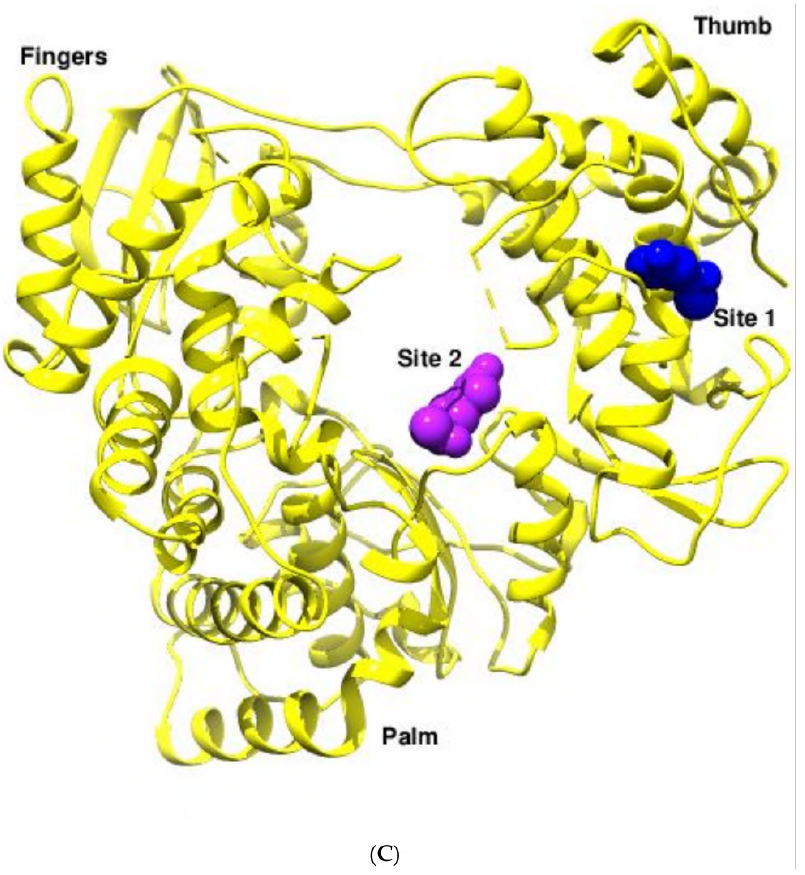
Figure 10. Inhibitor binding sites of DENV2 and SARS-CoV-2 RdRPs. ( A ) The binding sites of suramin derivatives in SARS-CoV-2 RdRP (yellow ribbon). The first one is near the active site (magenta), and the other site is located at the template binding region (blue). The NSP7 and NSP8 that are bound to the RdRP are shown in shades of blue. ( B ) The structure of SARS-CoV-2 RdRP with the bound nucleoside-analog remdesivir (green ball and stick). The template and the product are shown in yellow and orange, respectively. Ser861 obstructs the cyano group of the inhibitor during translocation. ( C ) The structure of the DENV2 RdRP showing the interactions with the inhibitor RK-0404678 at the active site (magenta) and in the thumb subdomain (blue). The inhibitor is shown as spheres and the RdRP is depicted as a yellow